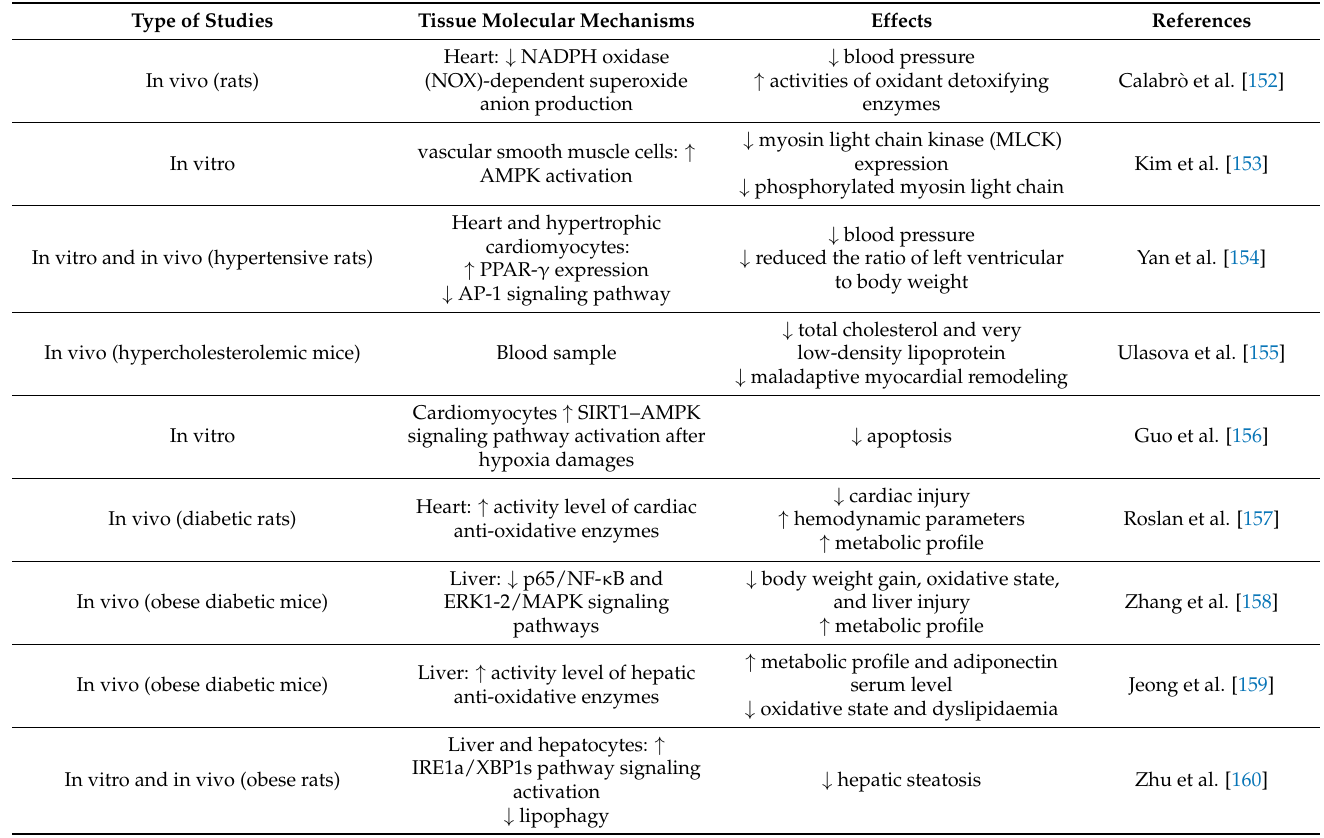
Table 3. Quercetin as a CR-related nutrient ( ↑ increase/improvement, ↓ decrease/worsening). Type of Studies Tissue Molecular Mechanisms